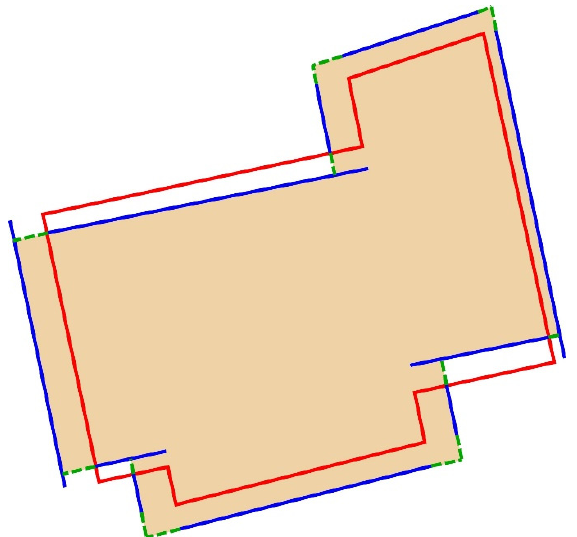
Figure 7. Schematic example of generated errors: red lines are the original polygon, blue lines are the separated and latterly shifted segments, green dotted lines are the extended lines, and the beige polygon is the newly formed polygon.